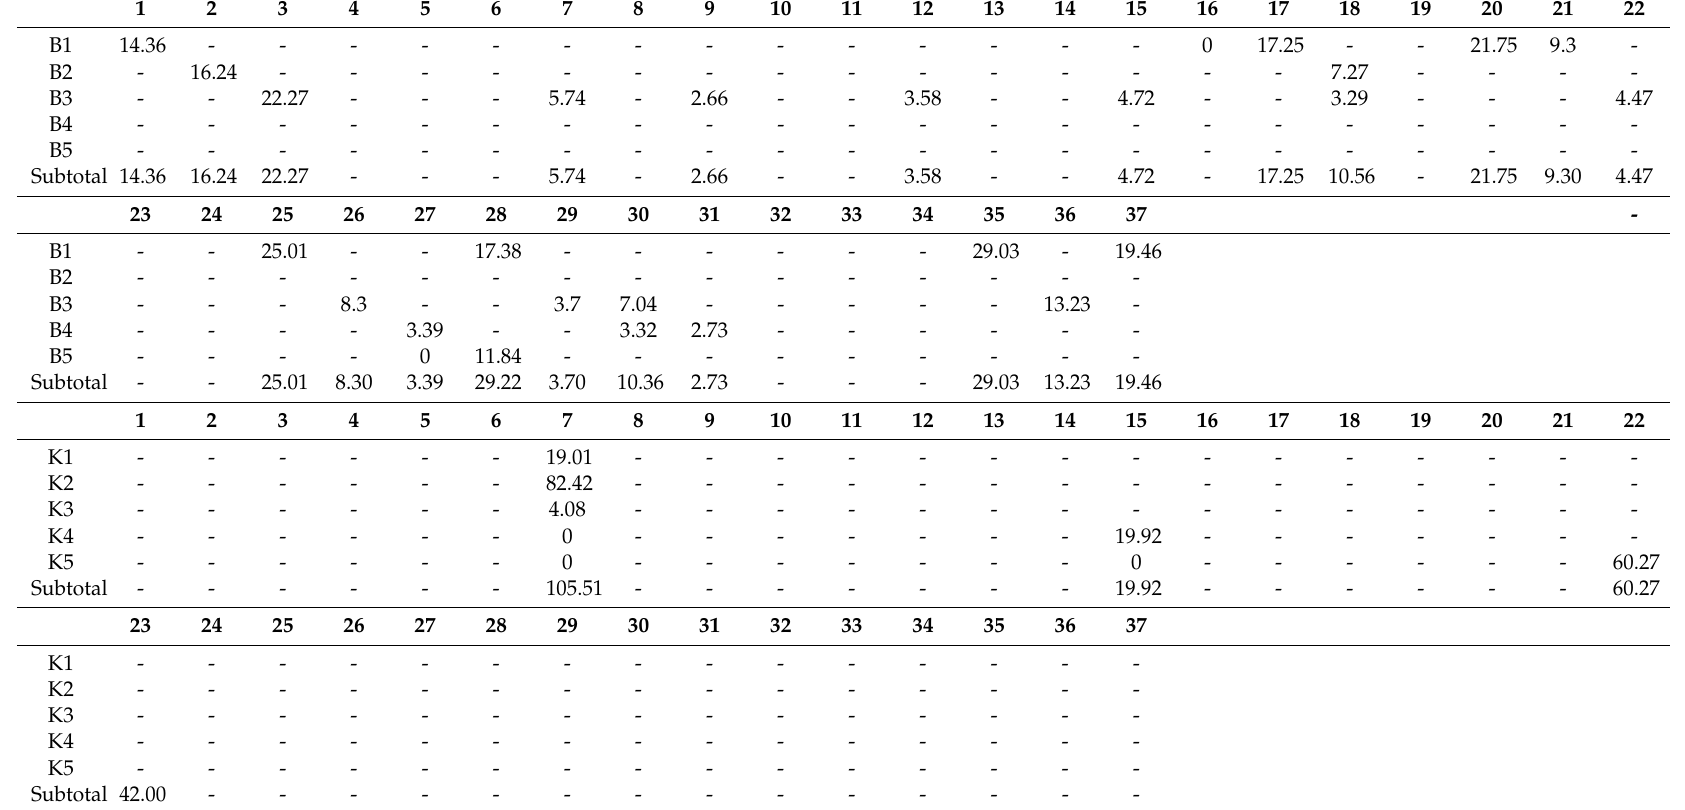
Table 7. Concentrations ( µ g/kg fresh weight (FW) equivalent of nonyl acetate) of volatiles alcohols and ketones in 37 mango